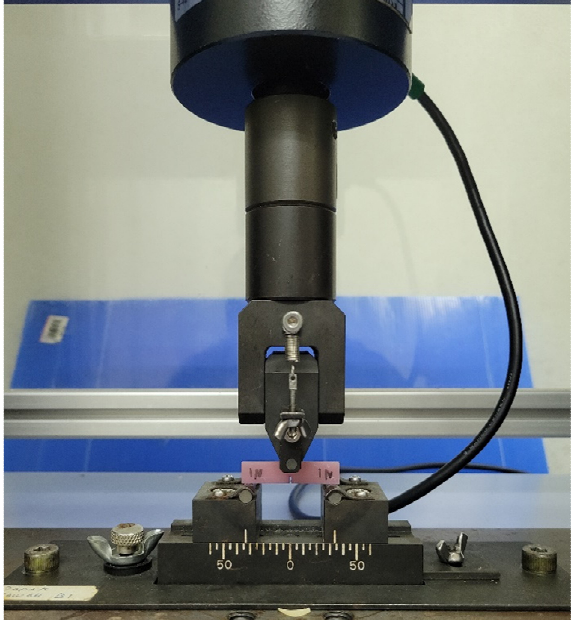
Figure 3. The 3-point bending test on Universal Testing Machine (UTM) (Fracture test) .